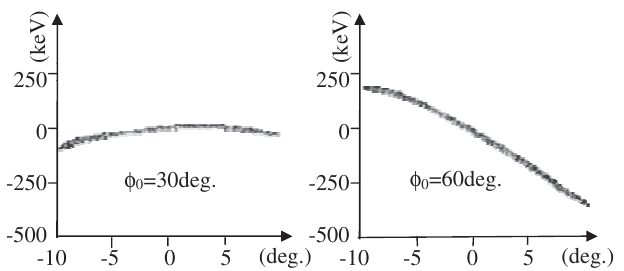
FIG. 7. (Color) Longitudinal phase-space at the gun’s exit for (cid:2) 30 (cid:11) (left), and (cid:9) (cid:2) 60 (cid:11) (right). (cid:9) 0 0 radius and a longitudinal Gaussian distribution with sigma of 15.8 ps bunch length; the peak field on the axis is 28 MV = m .